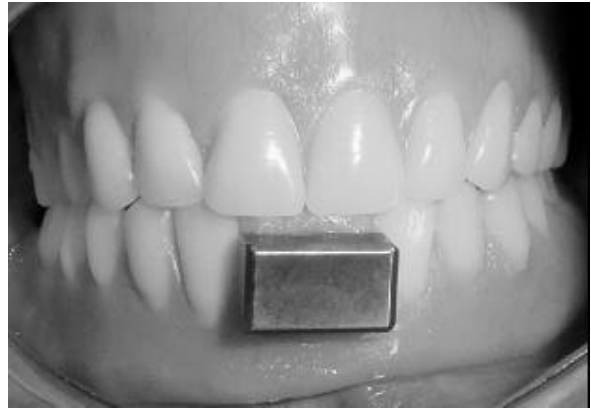
FIGURE 2- Magnet tracking device attached to the midline labial surface of the mandibular